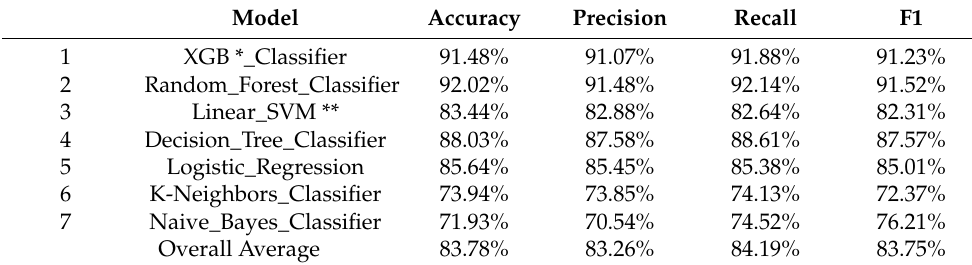
Table 8. Overall model accuracy.